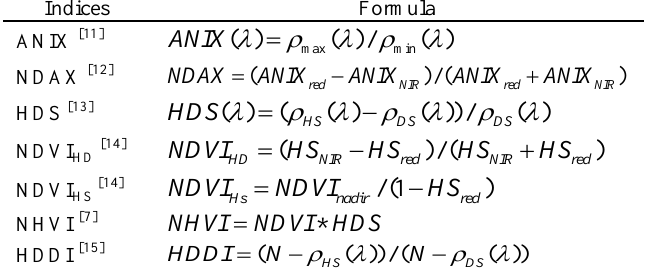
Table 1. Several multi-angular vegetation